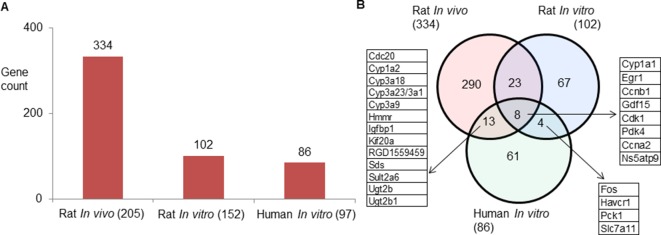

(A) Count of frequently differentially expressed genes in three test systems (rat in vivo/vitro and human in vitro). The total number of exposures in each test system is given in parenthesis. (B) Genes commonly expressed differentially across test systems. Eight genes were commonly differentially expressed in three test systems.